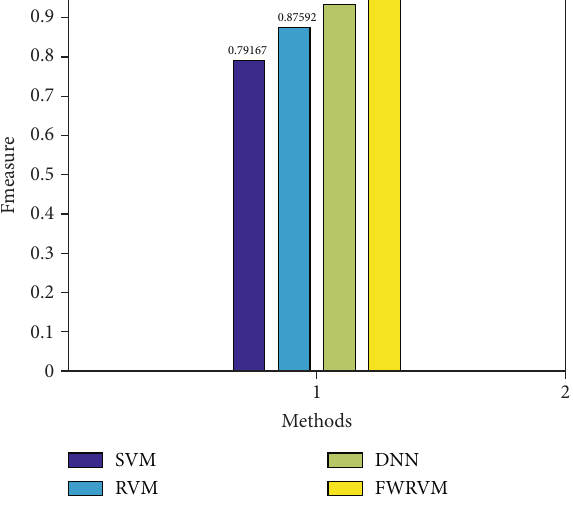
Figure 6: F-measure